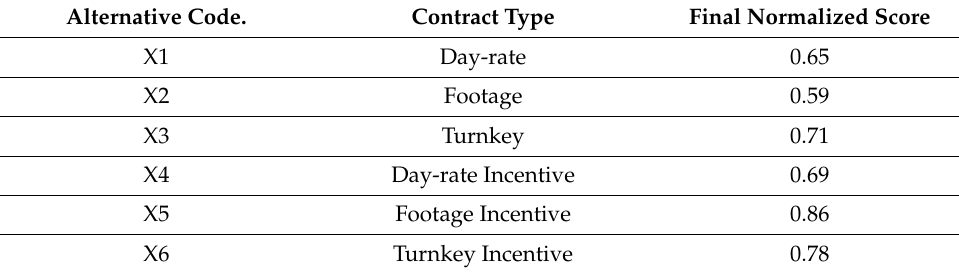
Table 9. Priority results for the drilling contracts according to the drilling risks. Alternative